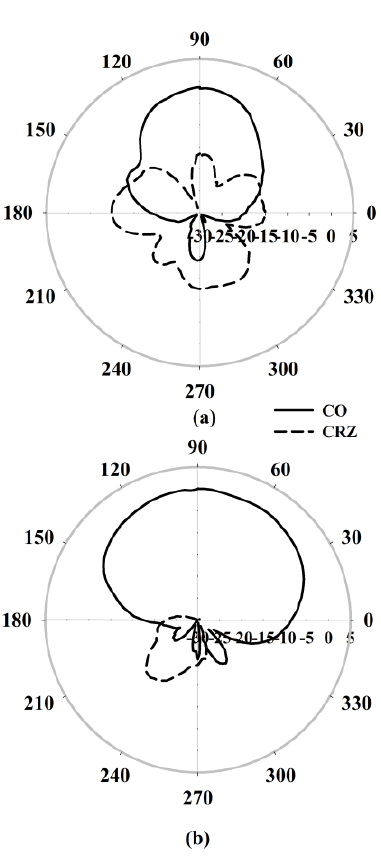
Figure 8: Measured radiation patterns of the antenna a) E- plane and b)